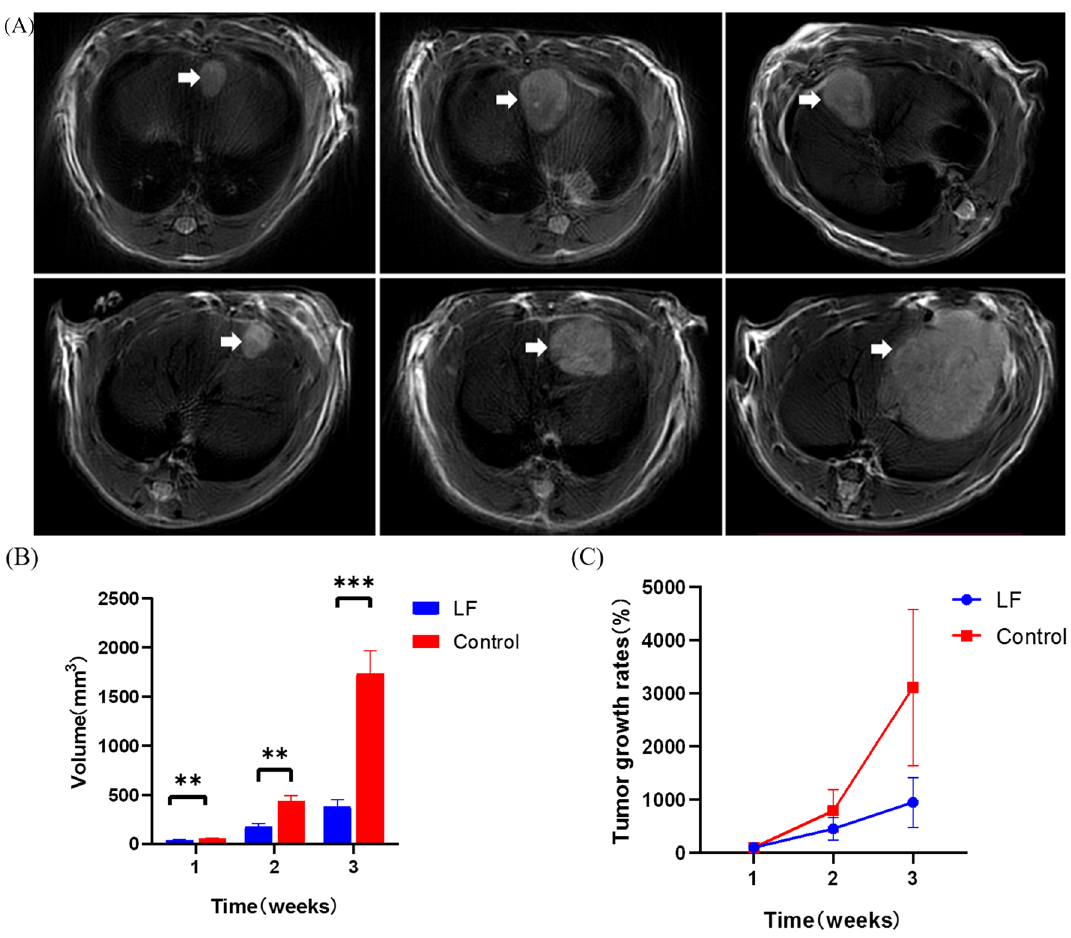
Figure 6. ( A ) MR dynamic detection of LF group and control group, tumor tissue showed high signal in T2WI sequence (white arrow); ( B ) Tumor volume changes of LF group and control group; ( C ) The tumor growth rates of LF group and control group. **P < 0.01; ***P < 0.001.